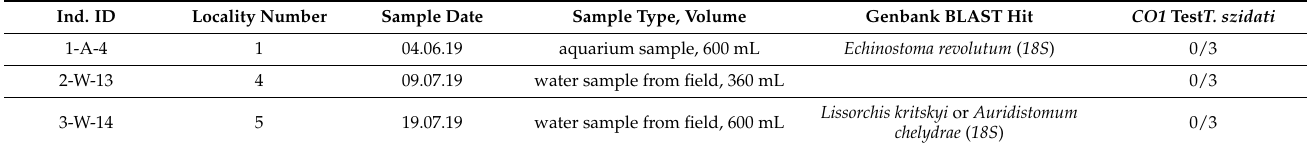
Table 5. List of eDNA samples analysed. Ind. ID = laboratory number of the sample or individual; Locality numbers in parentheses, for eDNA samples from aquariums, indicate the water body from which the snails originated. For all aquarium samples, the column “sample date” gives the day of eDNA sampling (in the lab). “Volume” indicates the amount of water sampled. The column “ CO1 Test T. szidati ” indicates the number of times the species-specific eDNA primer produced a positive PCR result for the species of concern. Genetic identification based on NCBI-BLAST results (all above 96%